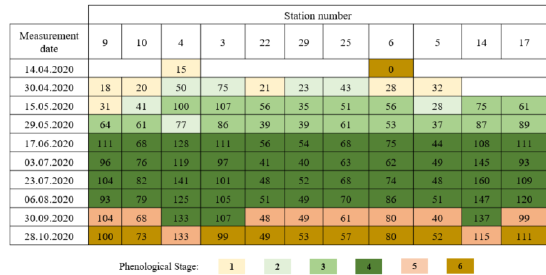
Figure 1: Geographical location of the study area in the Free State of Thuringia, Germany and reference points for fern measurements (color-coded) in the northern (top) and southern (bottom) part of the study area as well as the Sentinel-2 based tree cover density (TCD) of the coniferous forest surrounding the study site (left). (Copernicus Land Monitoring Service 2020) Table 1: Fern height [cm] and corresponding phenological stage at each measurement